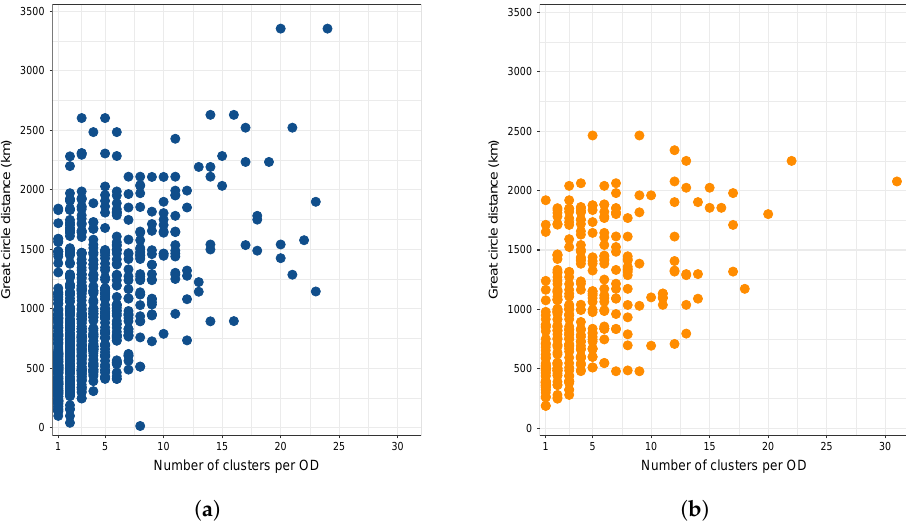
Figure 6. Relations between the flight cost profile, number of clusters and GCD between the ODs. ( a ) ODs with one cost profile; ( b ) ODs with two cost